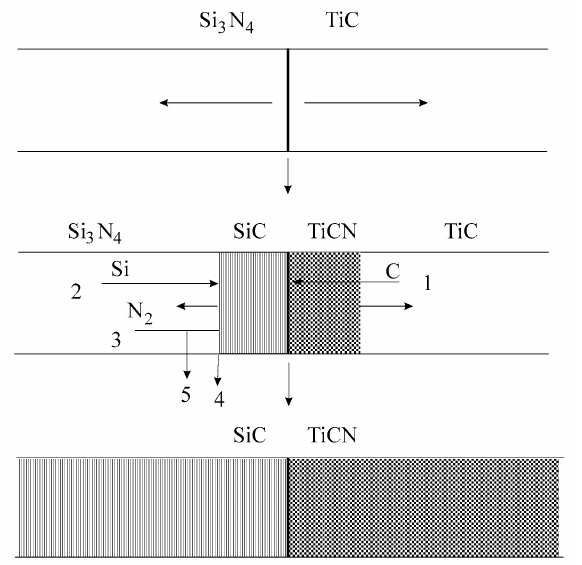
Figure 8. Schematic representation of the chemical interaction in the TiC-Si 3 N 4 system (see text for details).